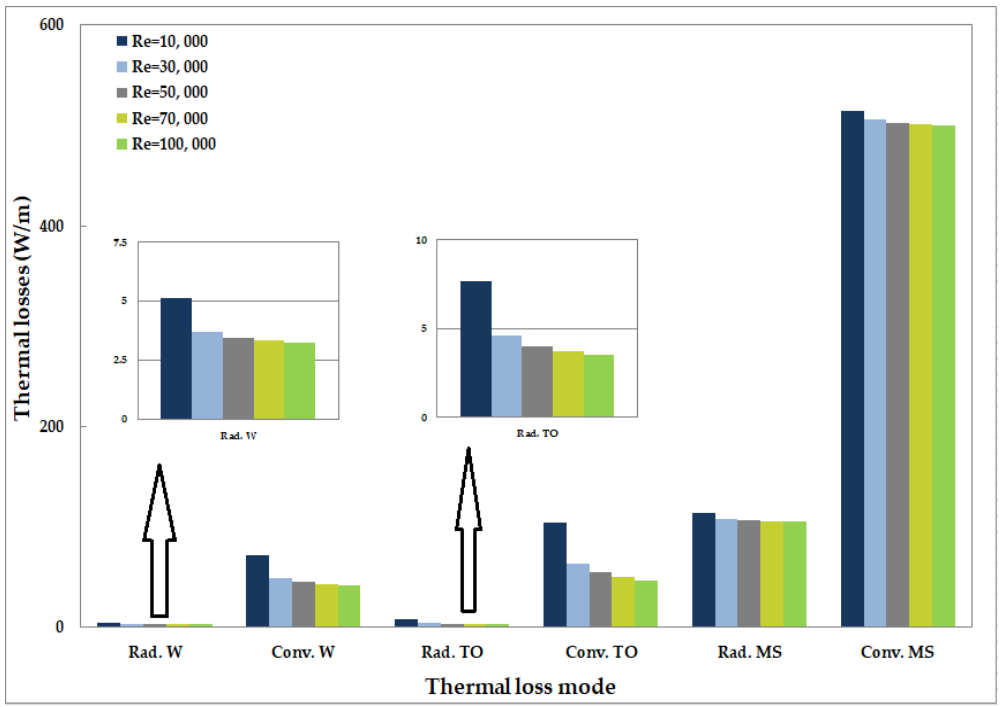
Figure 8. Convection and radiation thermal losses at different 𝑅𝑒 numbers at the smallest inlet temperatures of different fluids; W (Water), T (Therminol ® VP-1) and MS (Molten Salt).